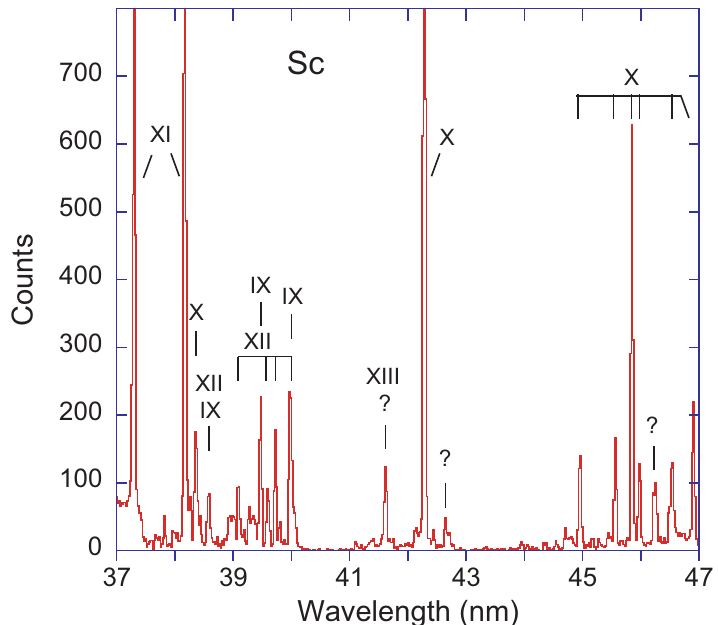
Figure 2. Beam-foil spectrum of Sc at an ion beam energy of 9MeV. Observation at the foil. Line width (FWHM) 0.045nm. The charge state distribution peaks at q = 9 + . The strongest lines are identified by the spectrum